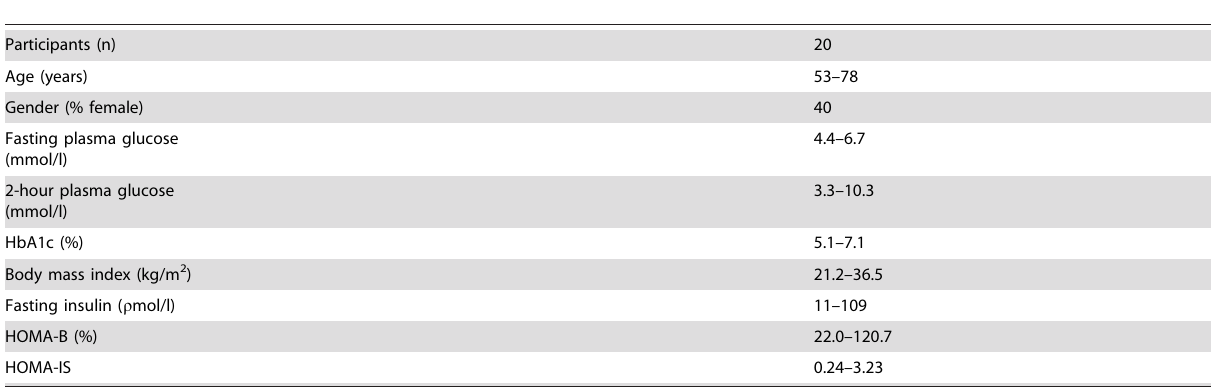
Table 1. Characteristics of the investigated ADDITION-PRO